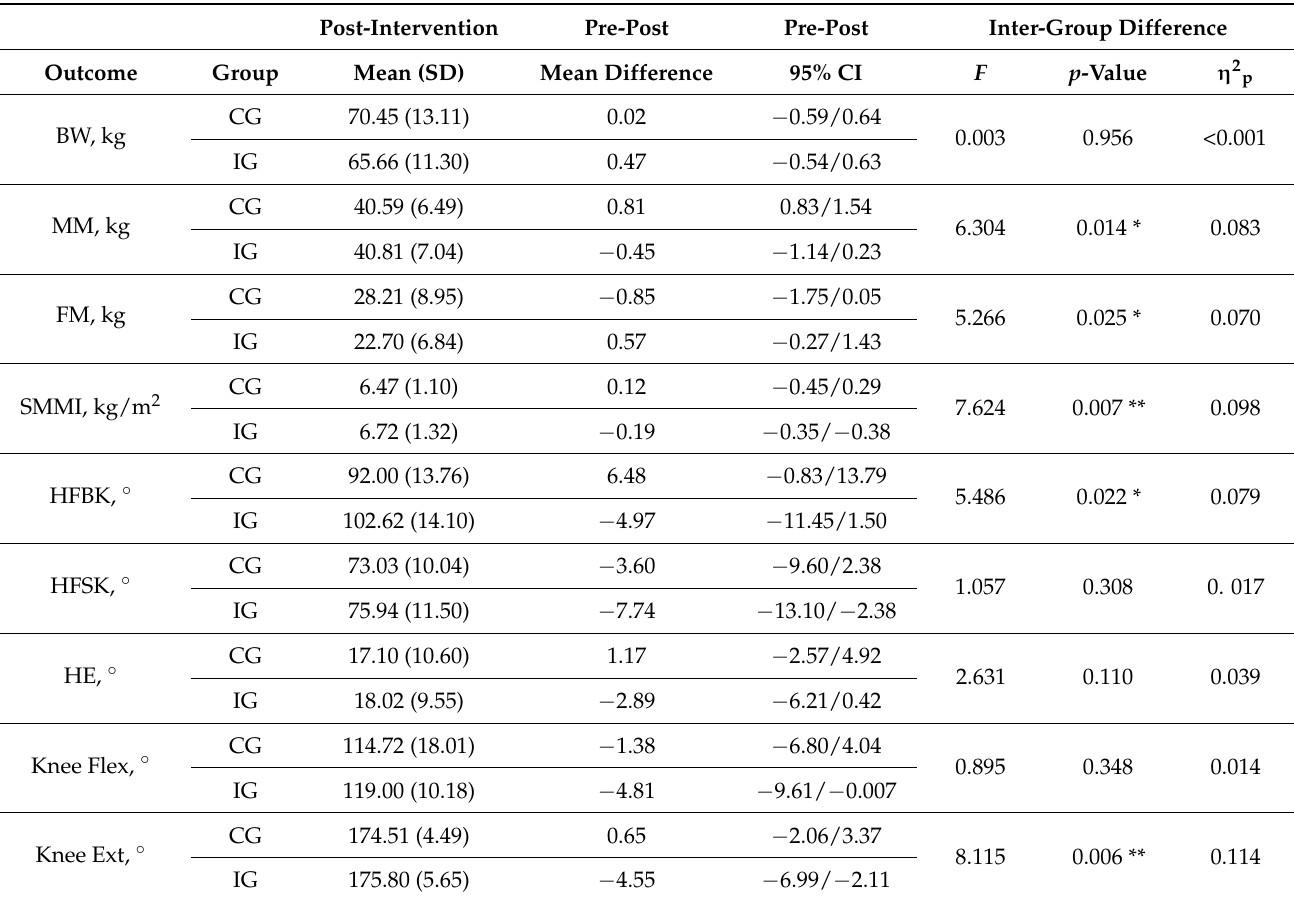
Table 2. Pre and post intervention values and time × group comparative analysis of the kinanthropo- metric